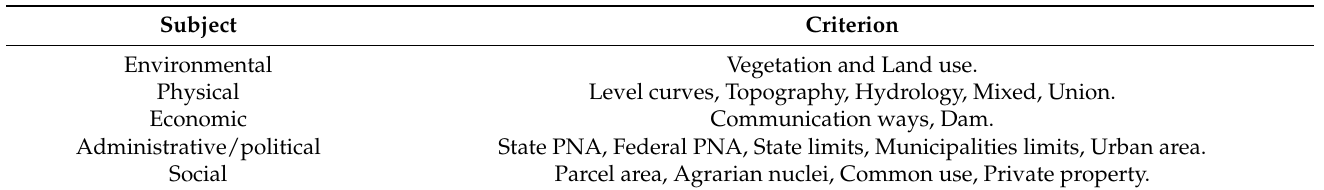
Table 4. Criteria for the delimitation of the polygonal of the proposed Protected Natural Area, Sierra de San Miguelito, San Luis Potosi.